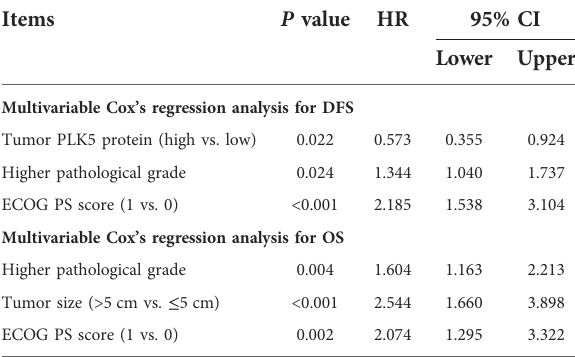
TABLE 4 Factors related to DFS and OS by cox ’ s proportional hazards regression analysis.